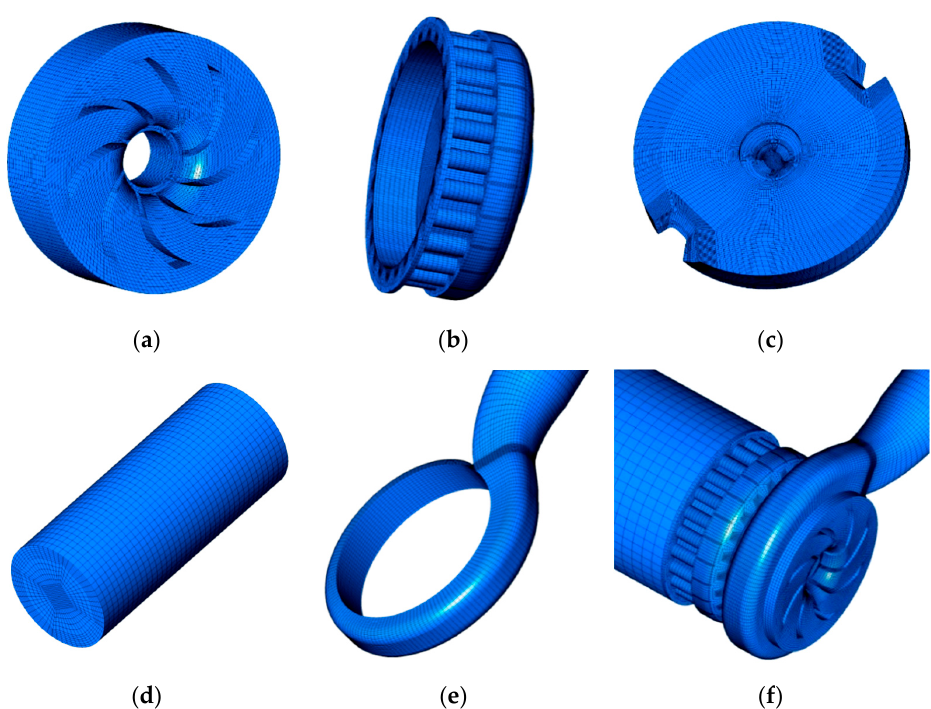
Figure 8. Flow components and assembly grid. ( a ) Impeller, ( b ) Static cutter and rear channel, ( c ) Moving cutter, ( d ) Inlet, ( e ) Volute, ( f ) Assembly.